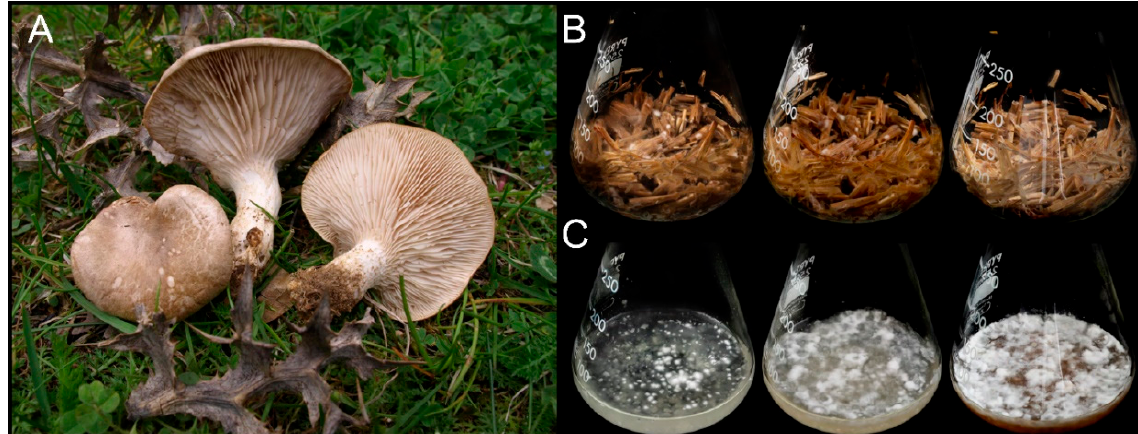
Figure 1. Pleurotus eryngii fruiting bodies ( A ), and monokaryotic (ATCC 90797) cultures on wheat–straw ( B ) and in glucose–ammonium medium ( C ) after 6 ( left ), 14 ( center ) and 43 ( right ) days of culture (image of fruit bodies courtesy of Dr J.M. Barrasa).